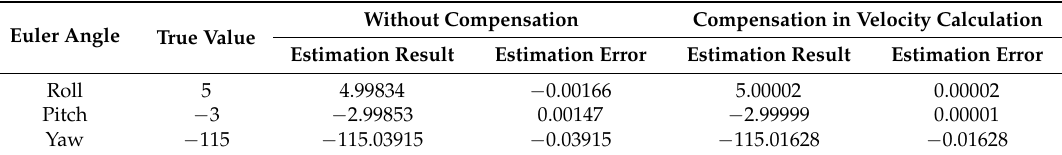
Table 4. When n frame is the navigation coordinate frame, estimation accuracy comparison of the simulations, unit: degree.